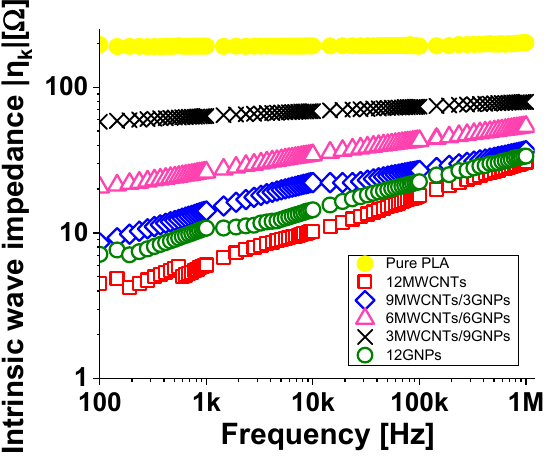
Figure 18. Intrinsic wave impedance (in modulus) of nanocomposites materials at 12 wt % of total charge.